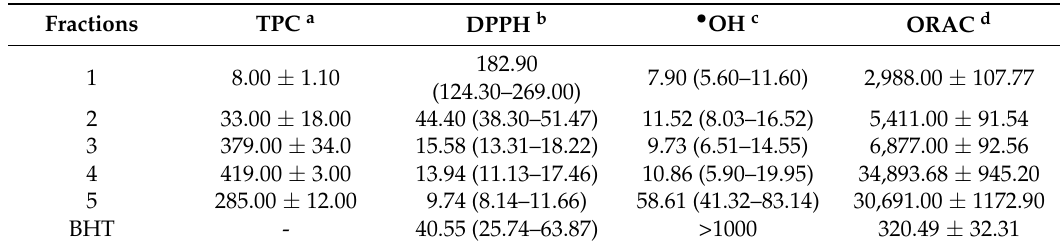
Table 1. Total phenolic content and antioxidant activity of Fucus spiralis fractions.